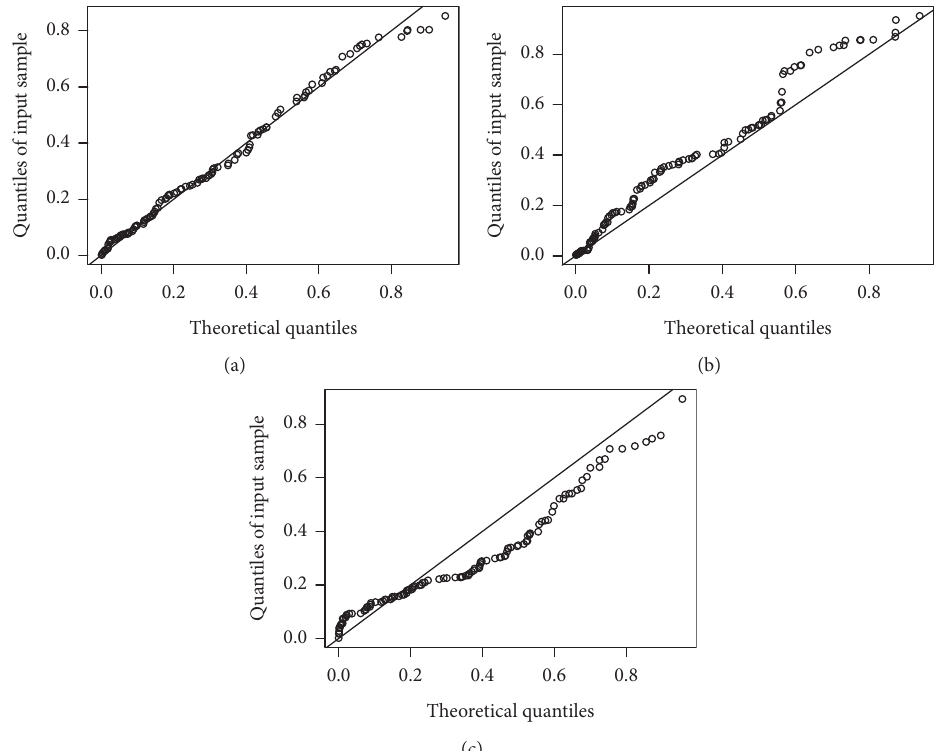
Figure 8: Q-Q plots of Clayton Copula (a), Gumbel Copula (b), and Frank Copula